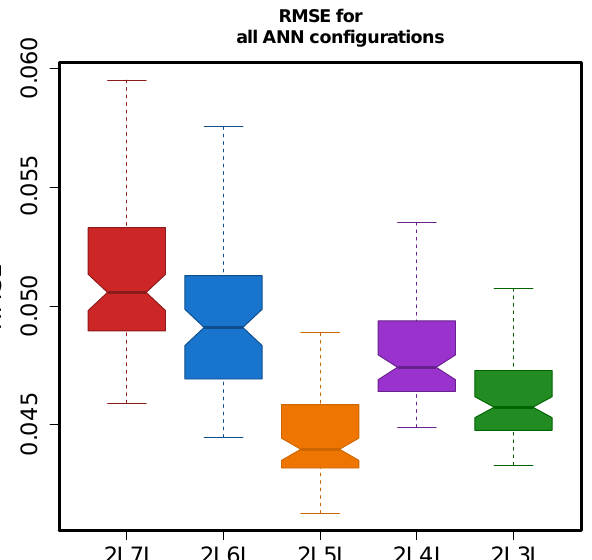
Figure 8. Boxplot for each run of the train package. The names means two hidden layers and the number of input data used in each